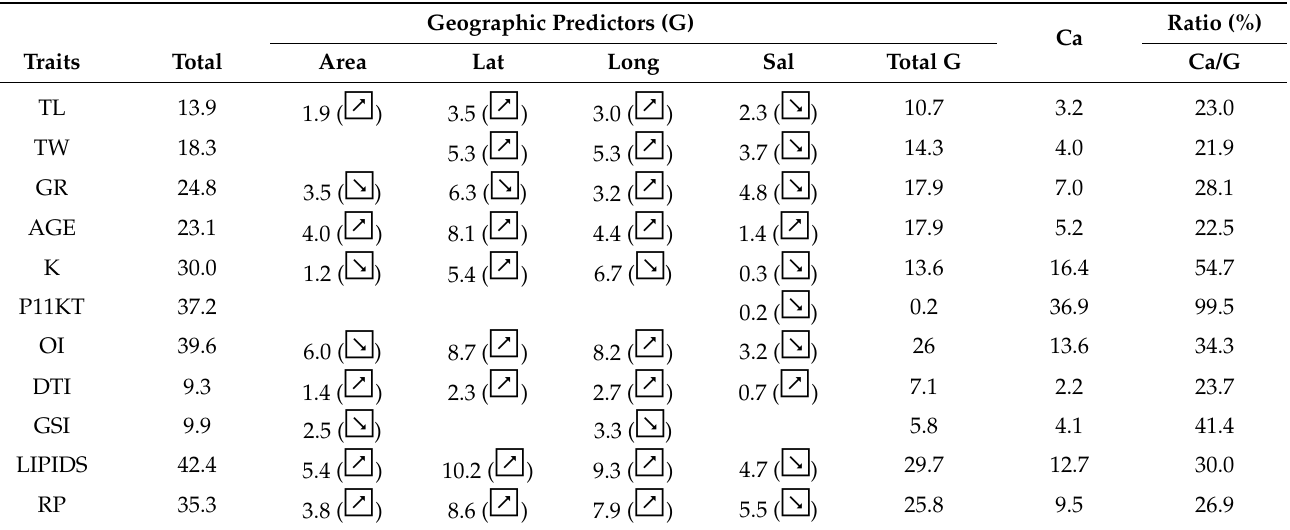
Model performance is expressed as pseudo-variance (R², %) scores that explain the variation in the fitness-related traits of female silver eels given for significant geographic (G; Lat: latitude; Long: longitude; Sal: salinity), local (catchment effect Ca) and contamination (C) predictors. Different ratios were calculated: C/G (relative importance of the contaminants compared to the geographic predictors), TEs/POPs (trace elements (TEs) compared to muscular persistent organic pollutants (POPs)) and TE_gon/TEs (gonadic TEs compared to all TEs). The total variance represents the variance for all significant predictors, G predictors, TEs and POPs predictors and all C predictors. Empty cells correspond to non-significant predictors and arrows in parentheses indicate the correlation trends between significant G predictors and traits. All models have 75 eels except P11KT ( n = 62).